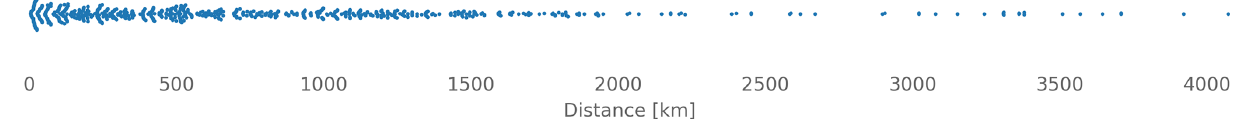
Figure 5. Swarm plot of the real-world distances of all catchments to the most hydrologically similar catchment (based on their distance in the PCA space of the hydrological